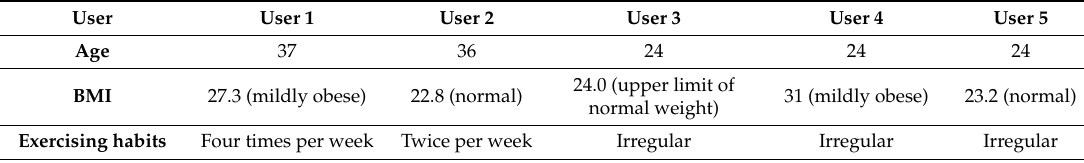
Table 5. Physiological differences between users for outdoor experiment.